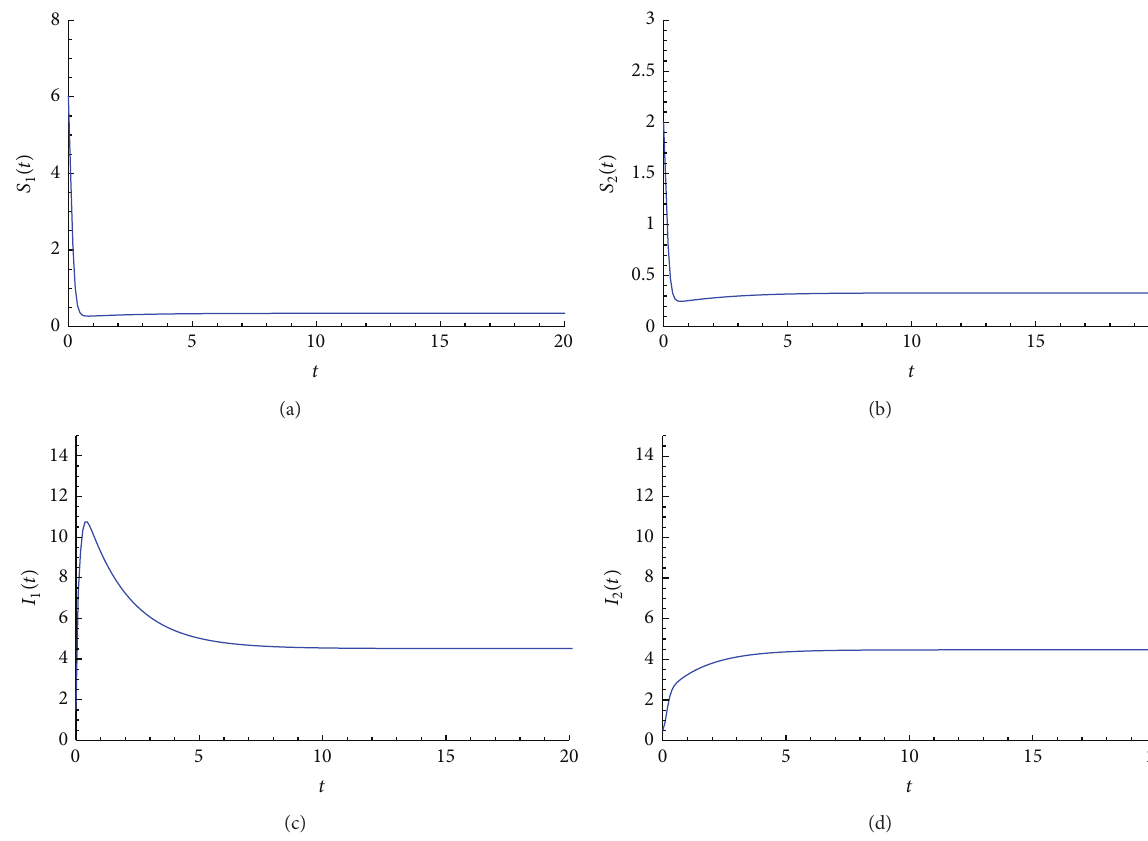
∗ = (0.347644, 0.0760948, 0.0760948, 4.51674, 0.330353,